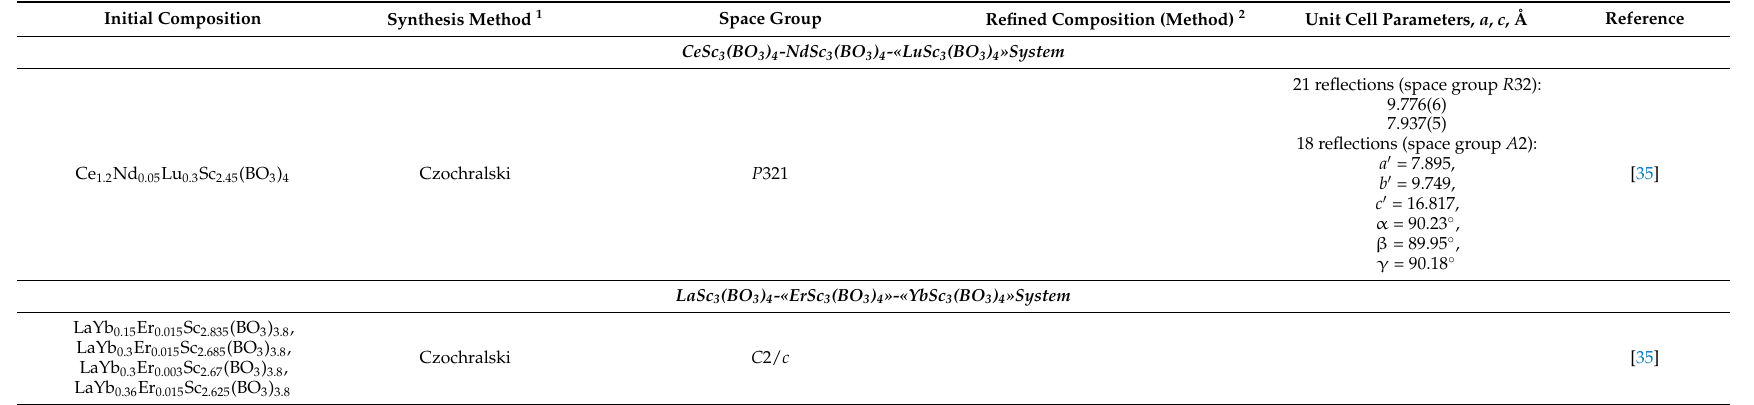
1 SSR—solid-state reaction; TSSG—top-seeded solution growth. 2 ICP—inductively coupled plasma elemental analysis; XRPD—X-ray powder diffraction; EDS—energy dispersive spectra standardless analysis; XRD—X-ray (single-crystal) diffraction; SEM/EDX—scanning electron microscopy with energy dispersive X-ray spectroscopy. 3 A structure and composition were refined in the space group